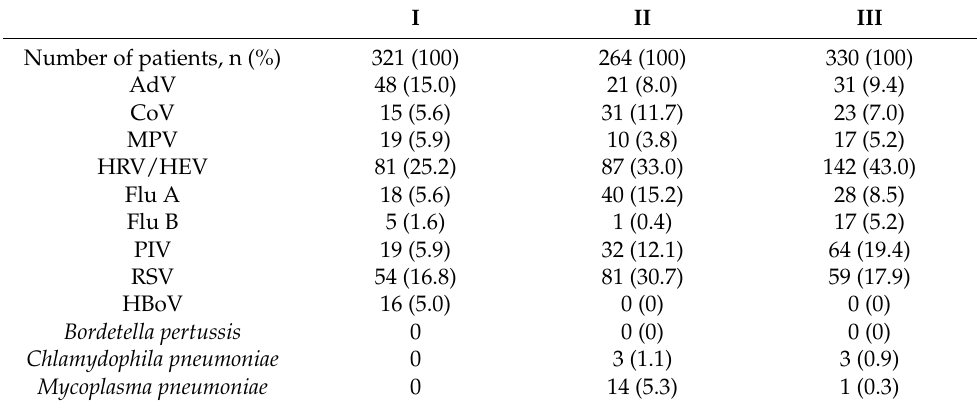
Table 3. Pathogens causing respiratory infections detected in different periods.